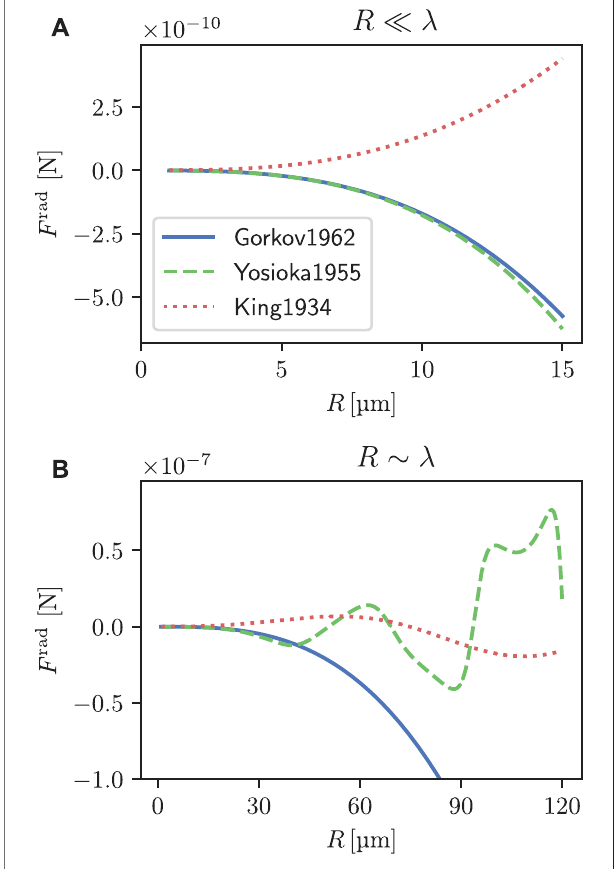
FIGURE 3 | Acoustic radiation force on an HFE oil droplet suspended in water placed halfway between the velocity node and the anti-node of a standing wave fi eld in the long-wavelength regime (A) and the intermediate wavelength regime (B)